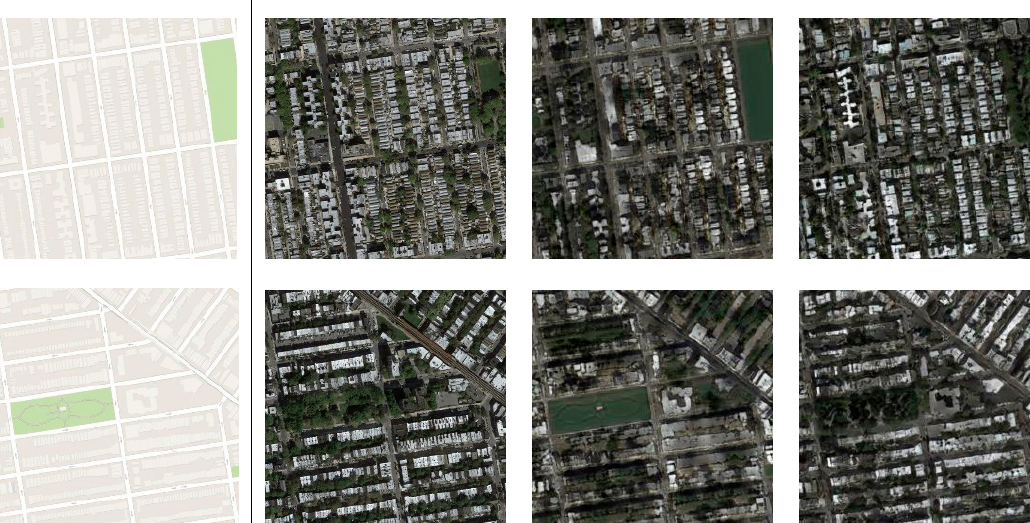
Figure 9. Comparison of the UNIT model and our model on paired datasets. On the cityscapes and night2day datasets, UNIT generates images with overly sharp textures, while our model generates a smoother, more natural texture. Additionally, UNIT results on the maps dataset show a missing “park” (green class in the input) section and a lower quality of building details than our method.